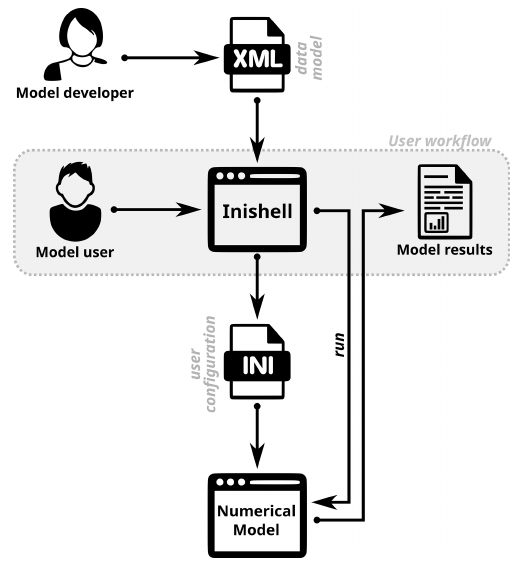
Figure 2. Overview of the Inishell workflows for model users and model